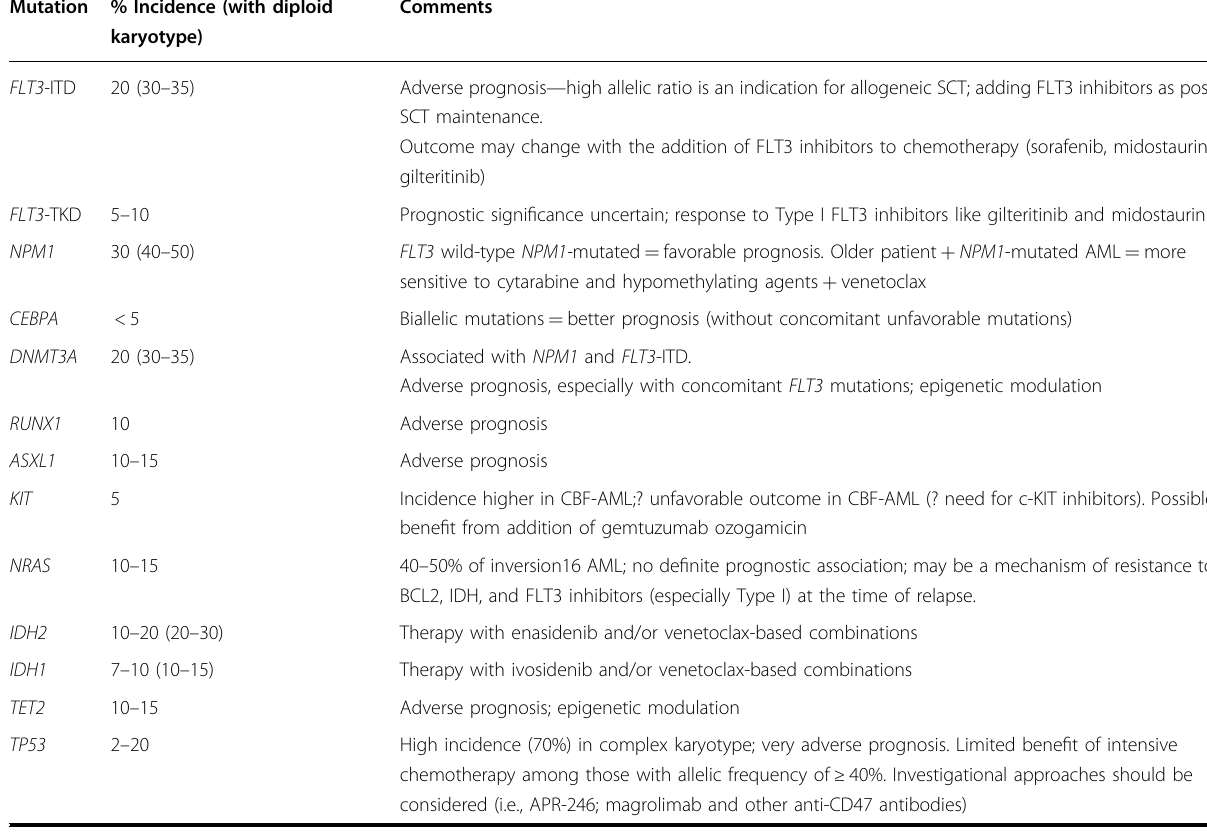
Table 3 Clinically relevant mutations in acute myeloid leukemia. Mutation % Incidence (with diploid